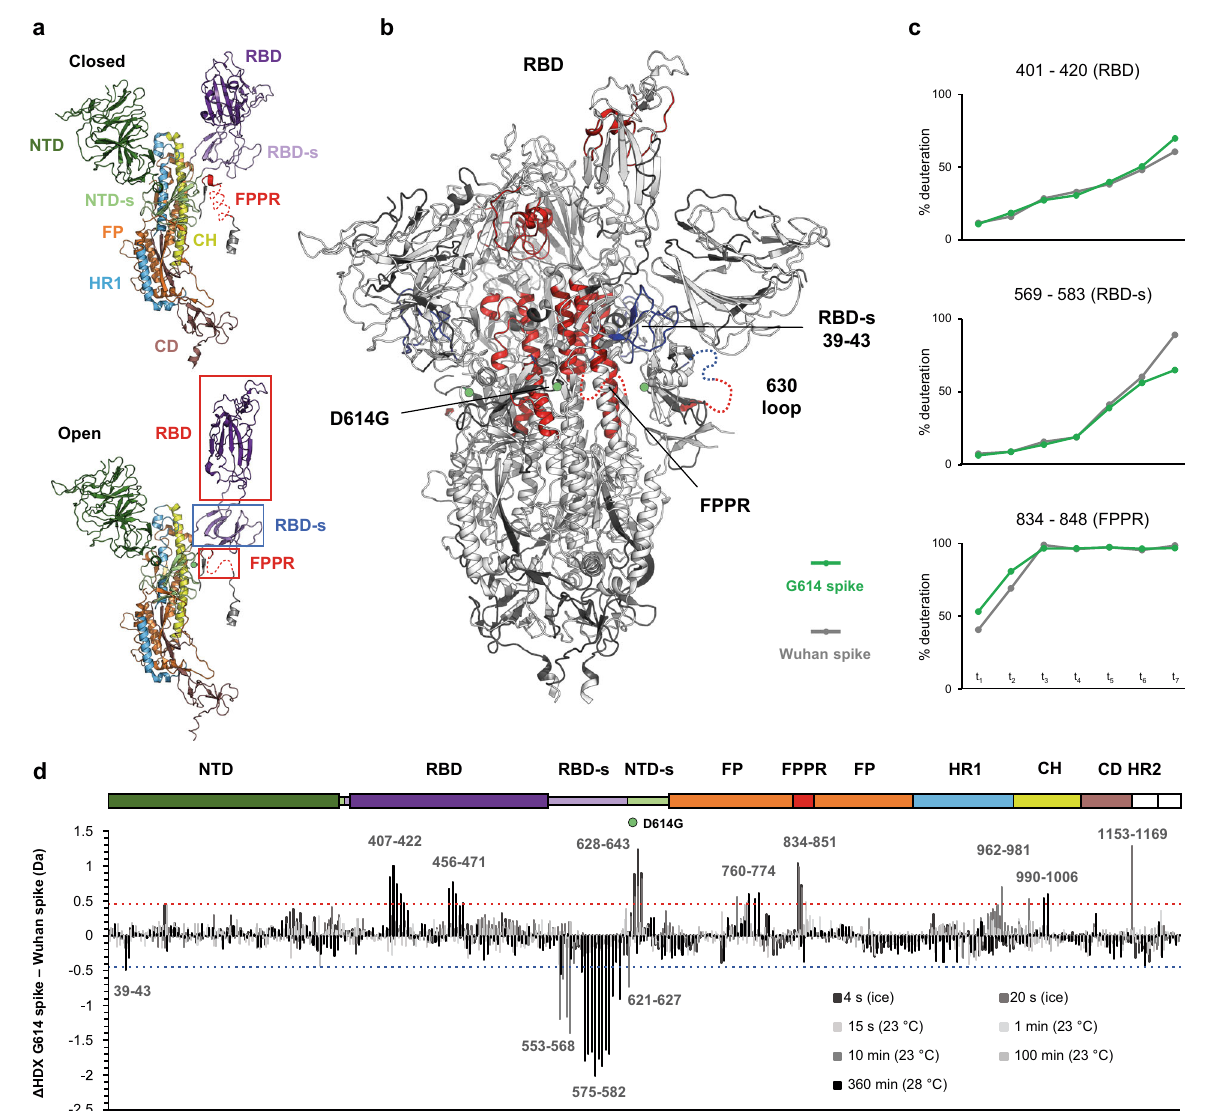
Fig. 1 | Differences in structural dynamics between Wuhan (D614) spike and G614 spike. a A single monomer in closed (top) and open (down) conformation is represented (PDB: 7bnn 18 ), with individual domains of spike indicated. b Regions with differencesinHDX are superimposed on the structureof G614 spike withone RBD erected (PDB: 7bnn 18 ), coloured in red for increased dynamics and in blue for reduced dynamics. Regions not mapped in the structure and showing HDX effects are inserted as dashed lines in one single protomer. c Uptake plots of model